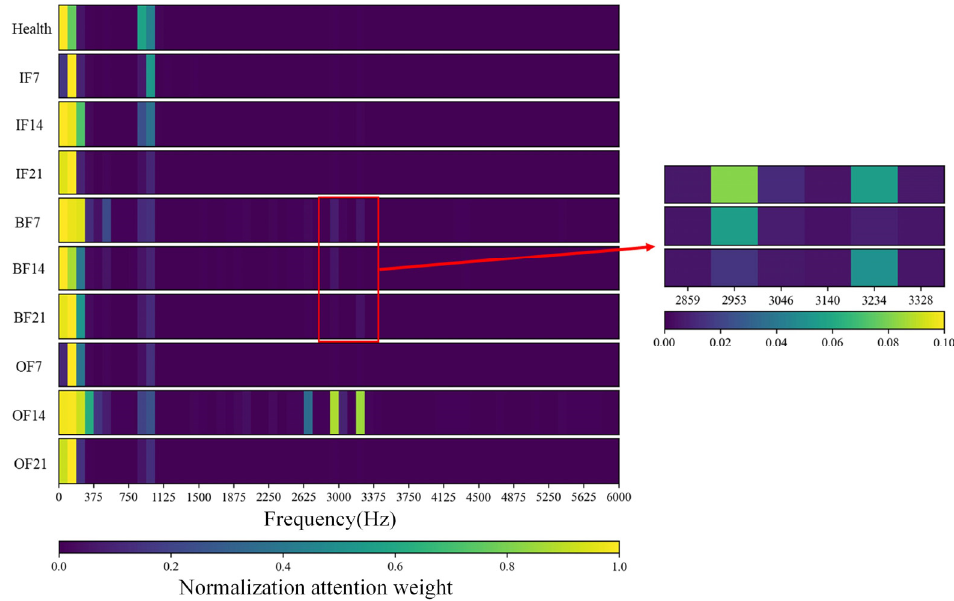
Figure 10. Average attention of each working